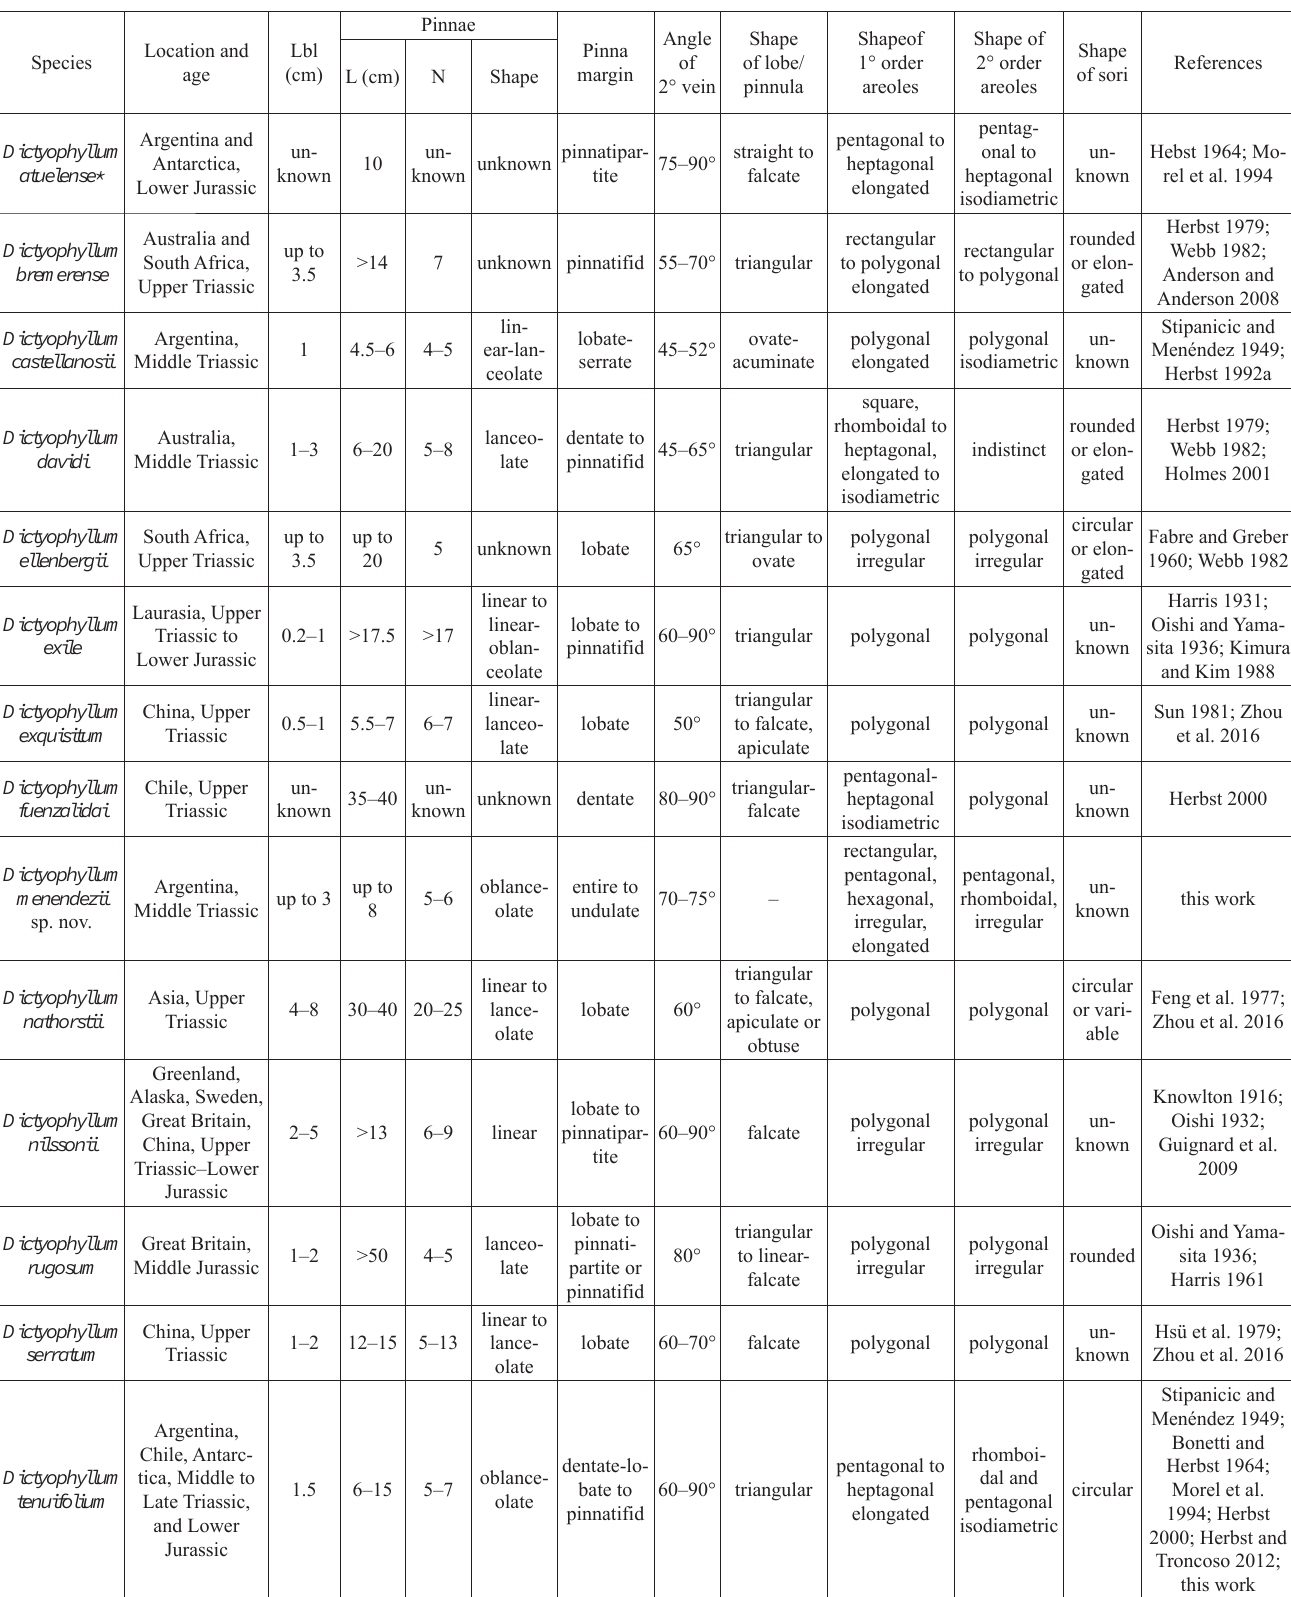
Table 1. Comparative table of the most representative species of the genus Dictyophyllum . *Some samples of Dictyophyllum atuelense were transferred to Goeppertella by Rees and Cleal (2004). Abbreviations: L, length; Lbl, length of basal lamina uniting adjacent pinnae; N, number on each